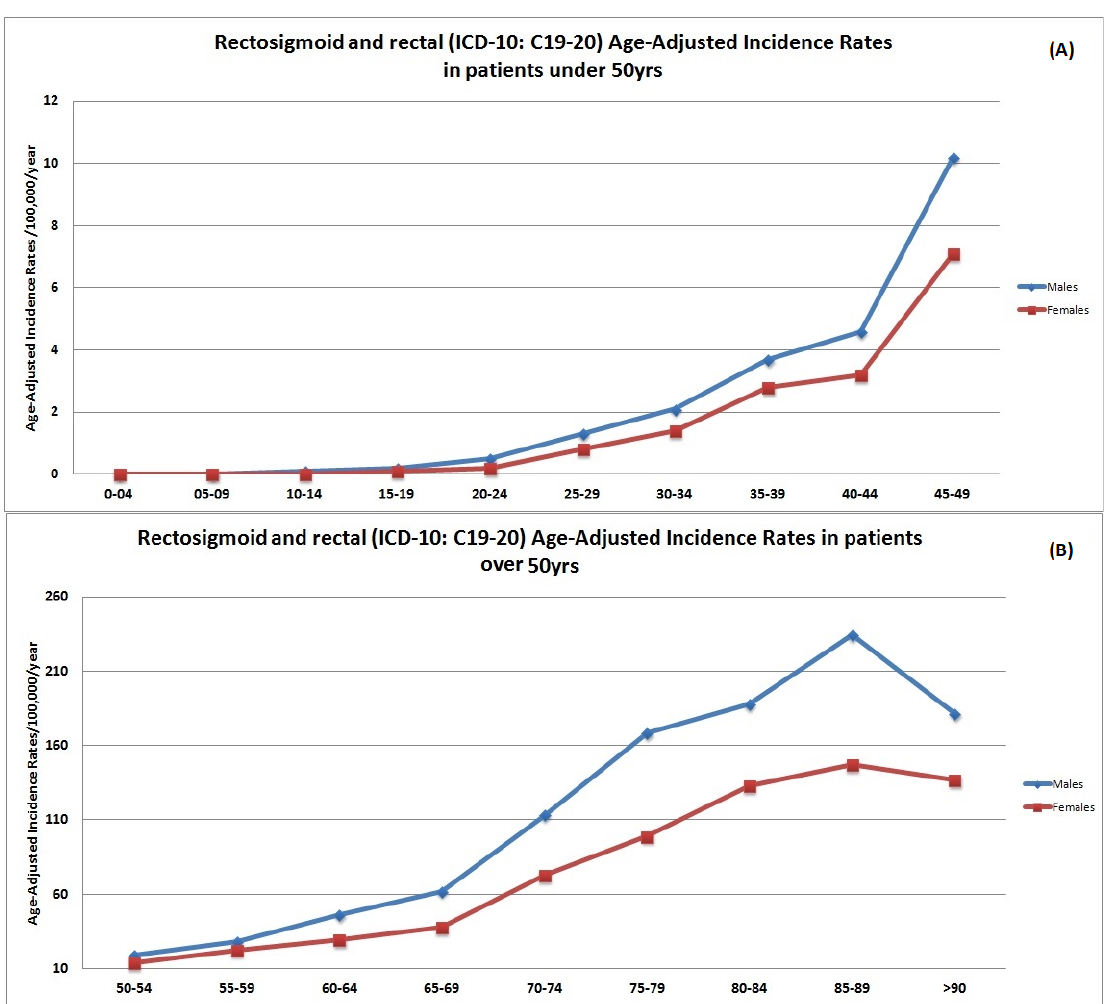
4.2/100,000/year (95% CI 3.8–4.6) (Figure 3A), while for patients ≥ 50 years the ASpIR was 96.9/100,000/year (95% CI 95.1–98.0) (Figure 3A). Males presented significantly higher rates compared with females ( p = 0.03), especially after the ages of 40, 75, and 85 years. The ASpIR presented decreasing trends after the age of 85 years (Figure 3B).